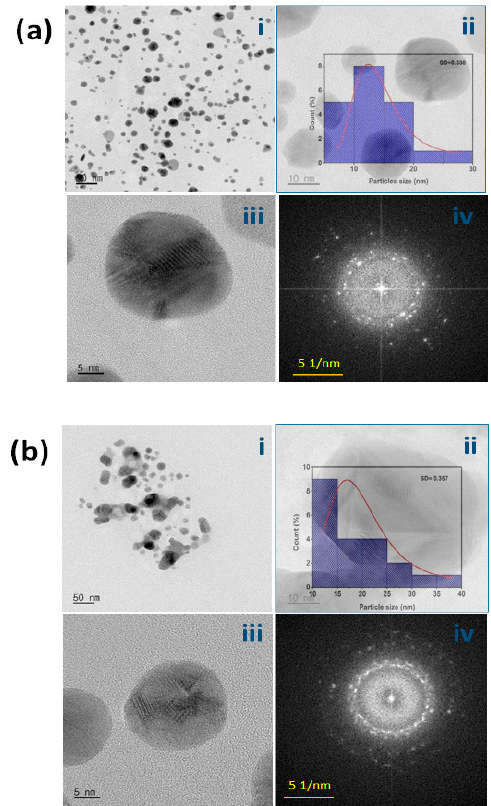
Figure 3. Transmission electron micrographs of SP-AuNPs and SP-AgNPs. ( a ) (i–iii) Shape and size of the synthesized AuNPs; scale = 50, 20, and 5 nm (inset: histogram of the particle size distribution of biosynthesized AuNPs analyzed using ImageJ). (iv) SAED pattern of AuNPs. ( b ) (i–iii) Shape and size of the synthesized AgNPs; scale bar = 50, 20, and 5 nm (inset: histogram of the particle size distribution of biosynthesized AgNPs analyzed using ImageJ). (iv) SAED pattern of AgNPs.